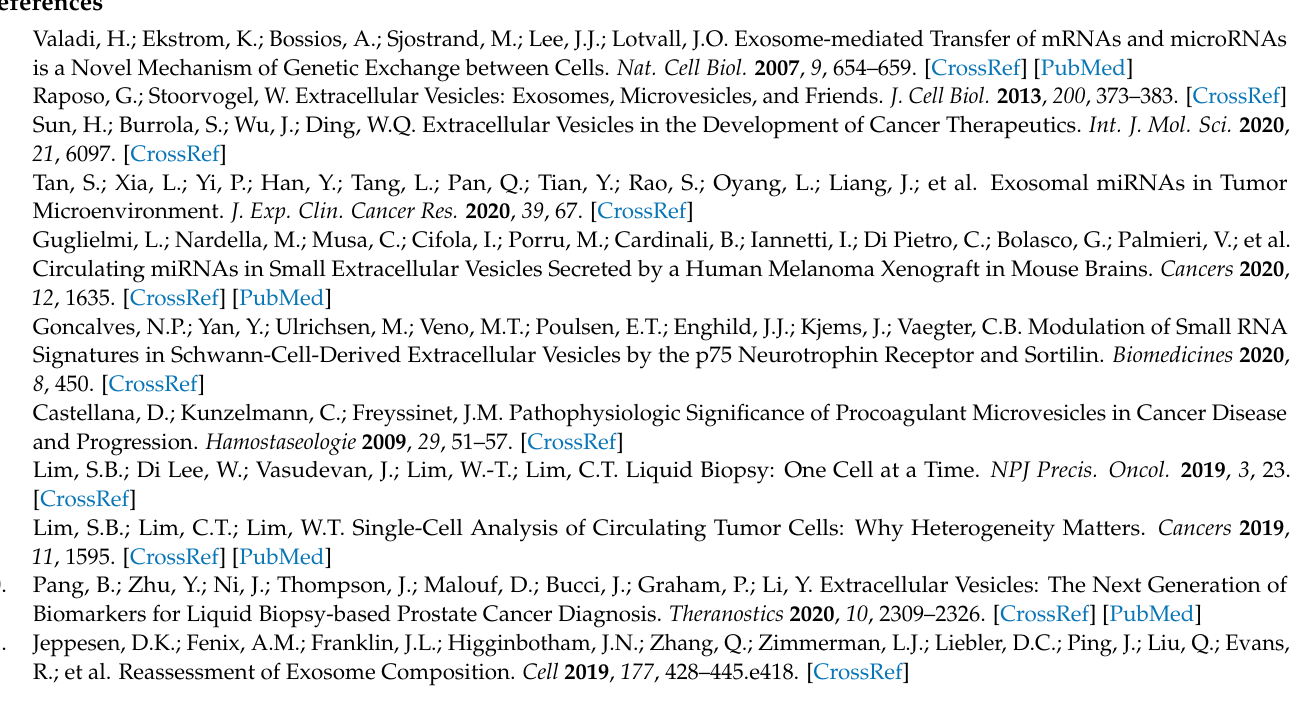
Figure S2: Comparison of mRNA profile between EVs and cells, Figure S3: Analysis of exosomal mRNA profile of the hypoxia gene panel, Figure S4: Fluorescent staining of CD63 and RNAs in MDA231 cells and EVs, Figure S5: Cancer EVs suppress cell proliferation, Figure S6: RNA-seq of HUVECs treated with cancer EVs, Table S1: Hypoxia-targeted gene panel, Table S2: Primer sequences for RT-qPCR, Dataset S1: RT-qPCR quantification results of cellular and exosomal